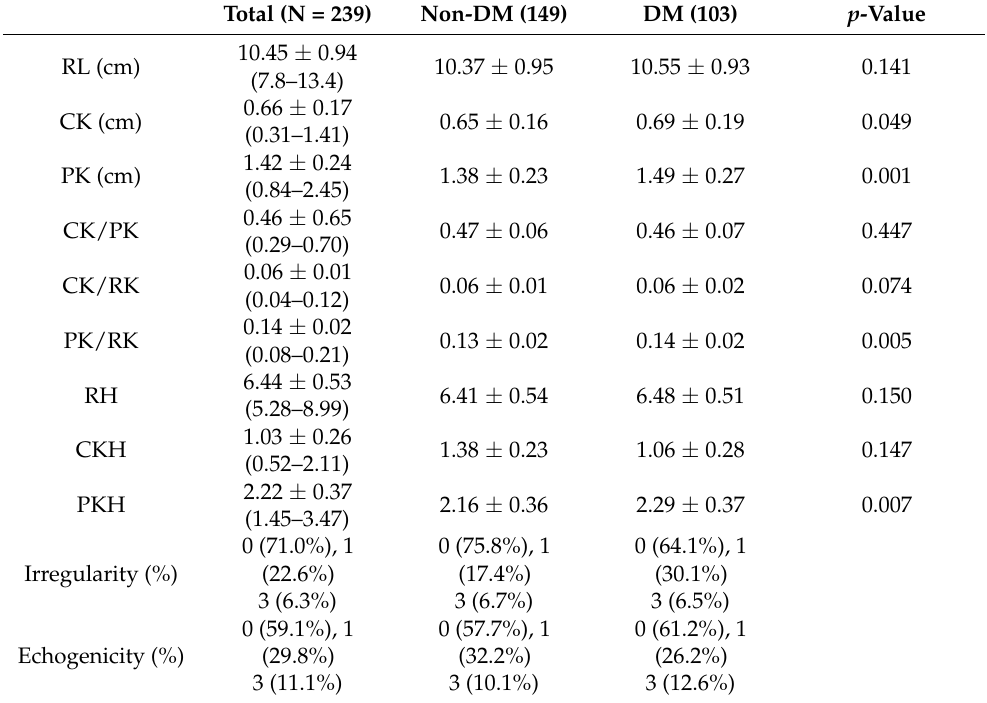
Table 3. Baseline ultrasound parameters of the study